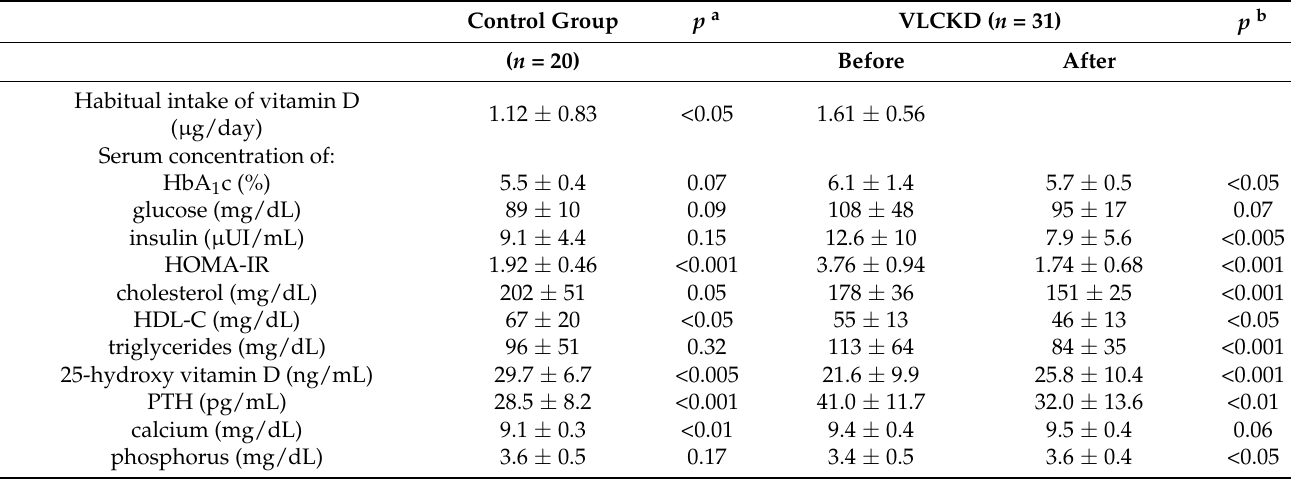
Table 2. Fasting serum concentration of the hormonal and biochemical variables of patients with obesity before and after dietary